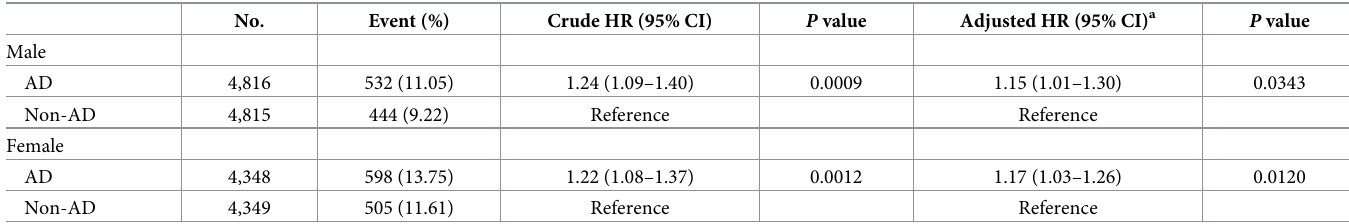
Table 3. Subgroup analysis of GERD risk based on sex.